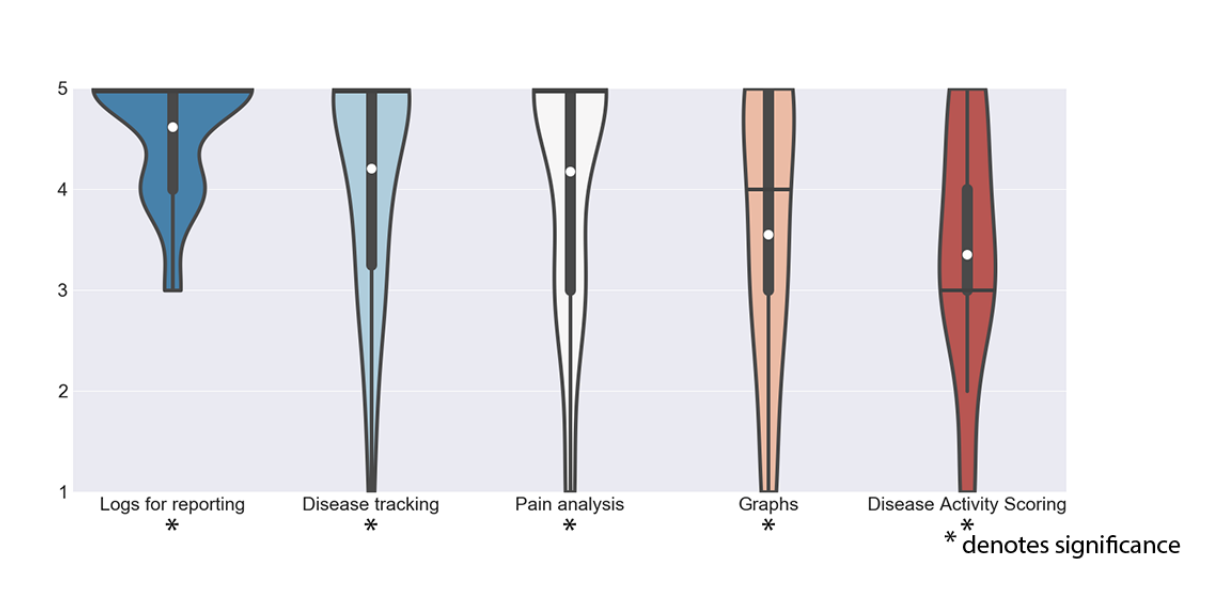
Figure 3. Scores of features in the group of disease insight. The white dot denotes the mean value, the horizontal black bar denotes the median value, the thick black bar denotes the interquartile range and the thin black bar denotes the 95% confidence